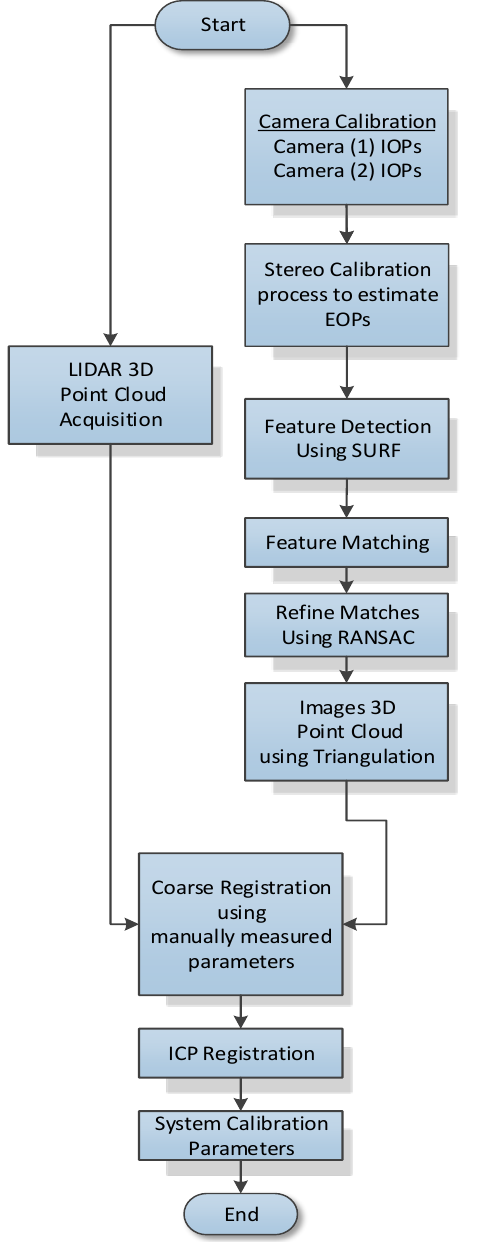
Figure 1. System overview